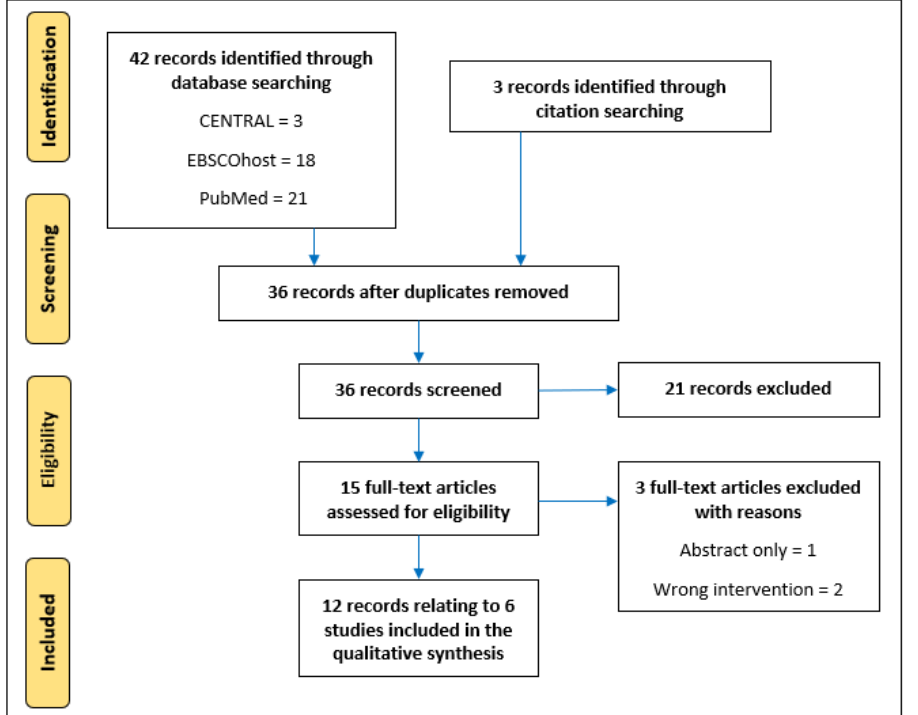
Figure 1. Flow diagram of database searches and study screening.